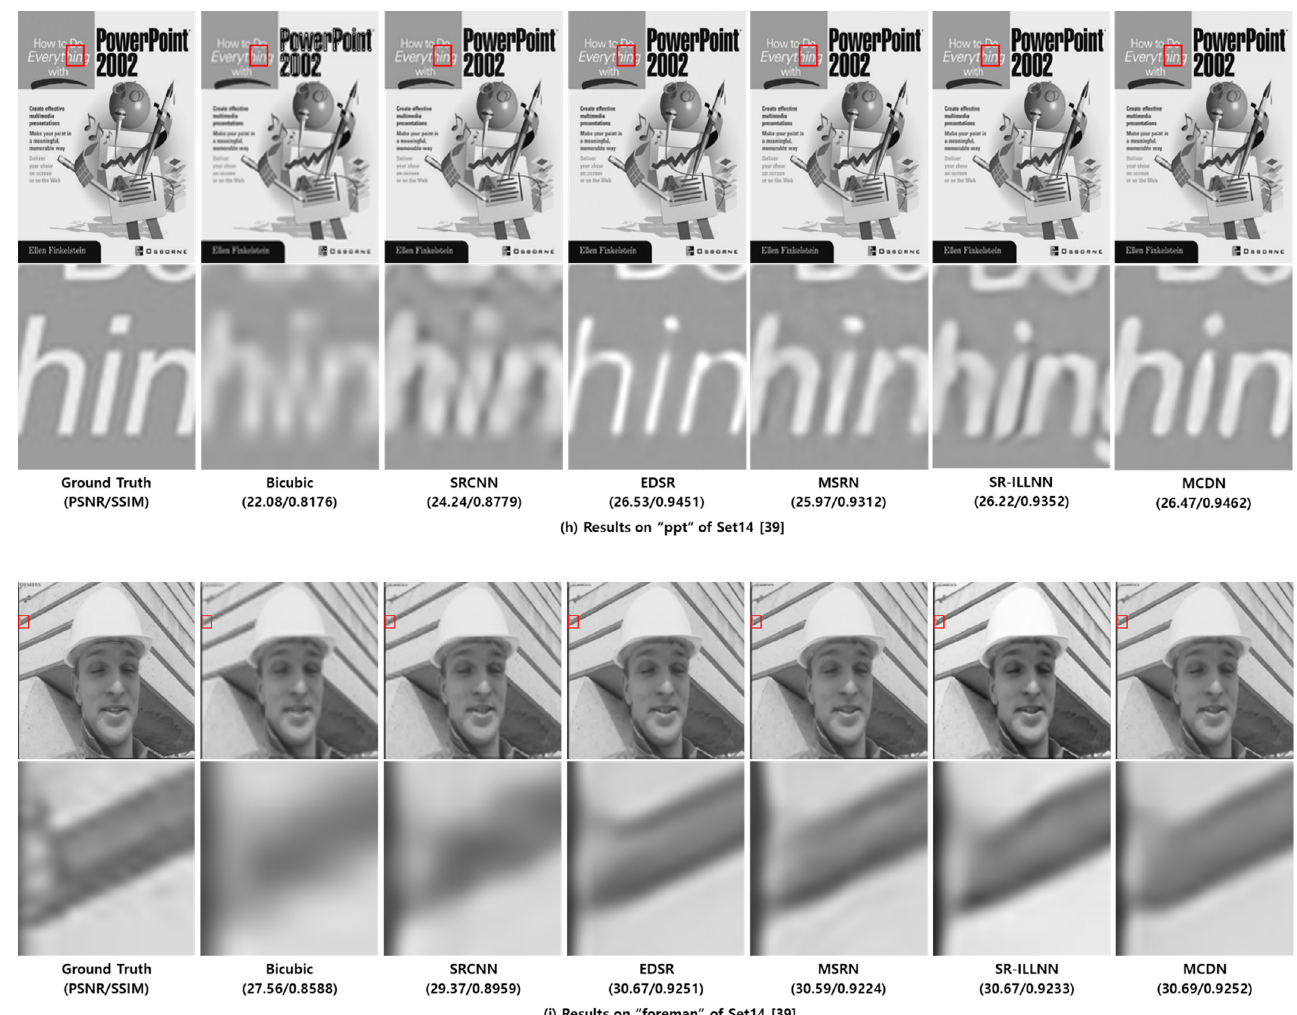
Figure 7. Visual comparisons on test dataset [38–41]. For each test image, the figures of the second row represent the zoom-in for the area indicated by the red box.